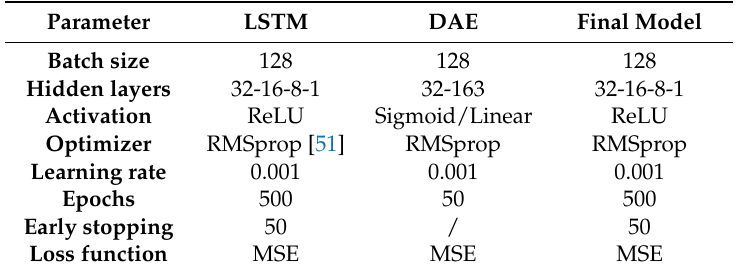
Table 1. List of hyperparameter values for network models.